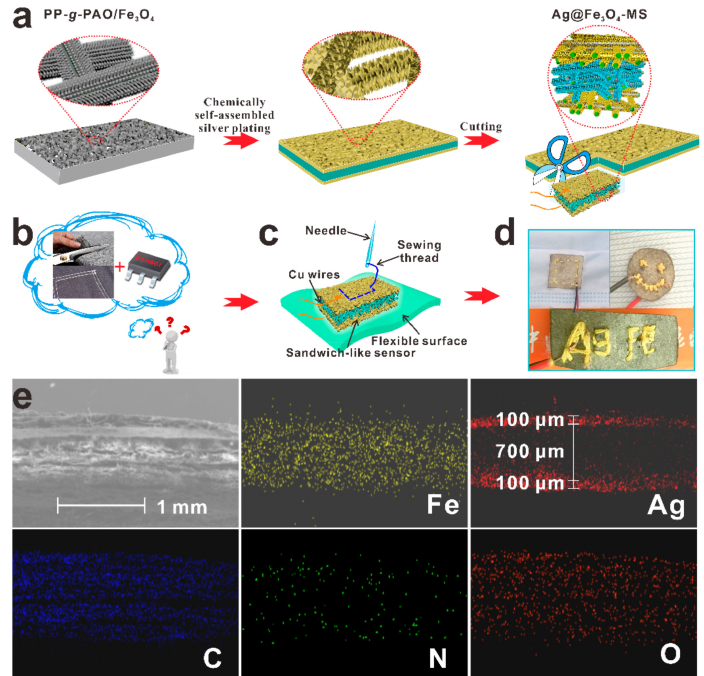
Figure 1. ( a ) Schematic fabrication process of the Ag@Fe 3 O 4 -MS sensor. ( b ) Ordinary fabric for cutting and sewing; a planar and strictly wafer-based sensor. ( c ) Illustration and ( d ) Photographs of humidity sensor: three-sublayered conductive architectures of the prepared Ag@Fe 3 O 4 -MS fabric sensor; e-fabric maintains the cutting and sewing properties of ordinary fabric. ( e ) Cross-sectional scanning electron microscopy (SEM) image and energy dispersive spectrometry (EDS) mapping image of Ag@Fe 3 O 4 -MS. Surface layer: 100 µ m; subsurface layer: 700 µ